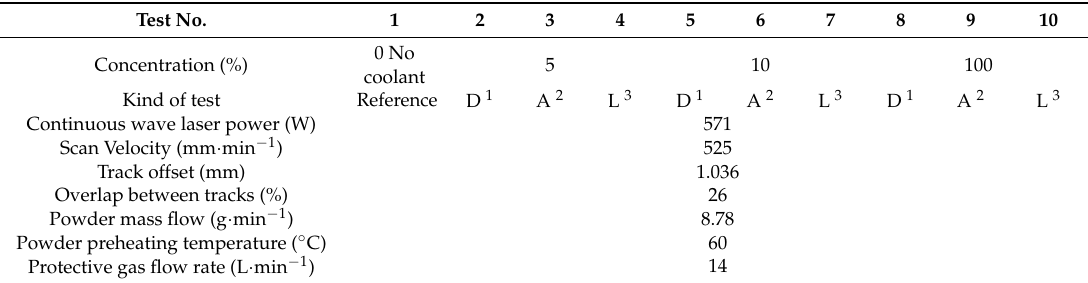
Table 2. List of experiments and Laser Metal Deposition (LMD) process parameters. Test